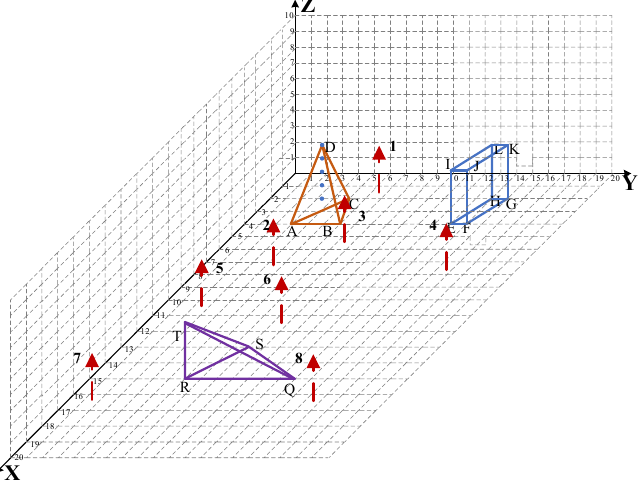
Figure 8. Sketch of VTS radar station environment. Table 2. Relevant information of water area. Water Area Serial Number Water Area Coordinates Area Figure 7. Sketch of VTS radar station environment.